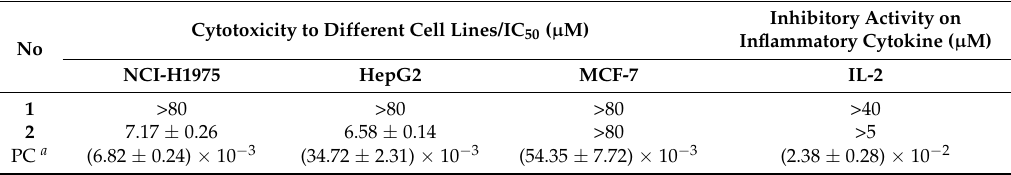
Table 2. Cytotoxicity and Anti-inflammatory activity of compounds from D. taliense . Cytotoxicity to Different Cell Lines/IC 50 ( µ No